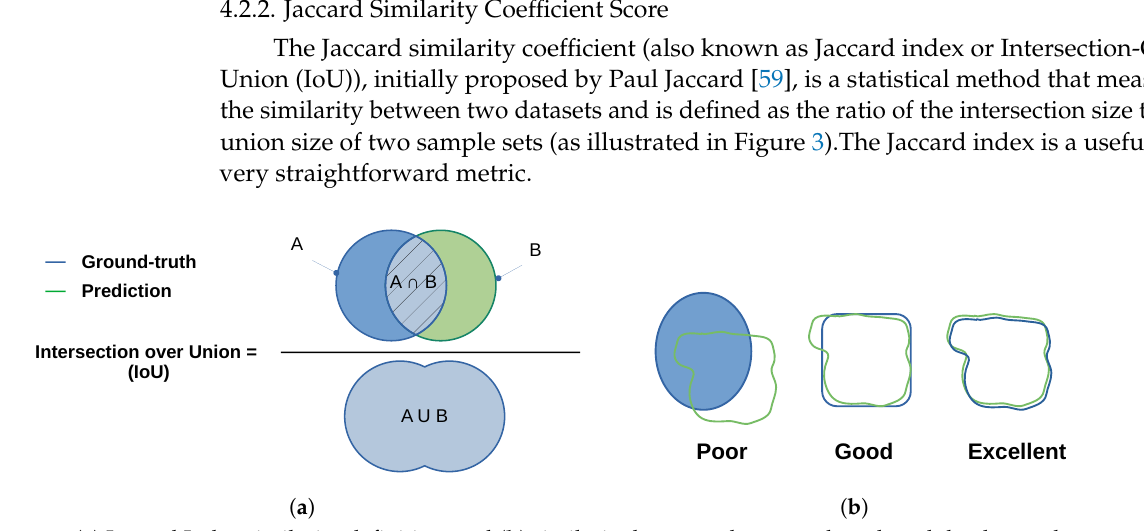
Figure 3. ( a ) Jaccard Index similarity definition; and ( b ) similarity between the ground-truth and the detected